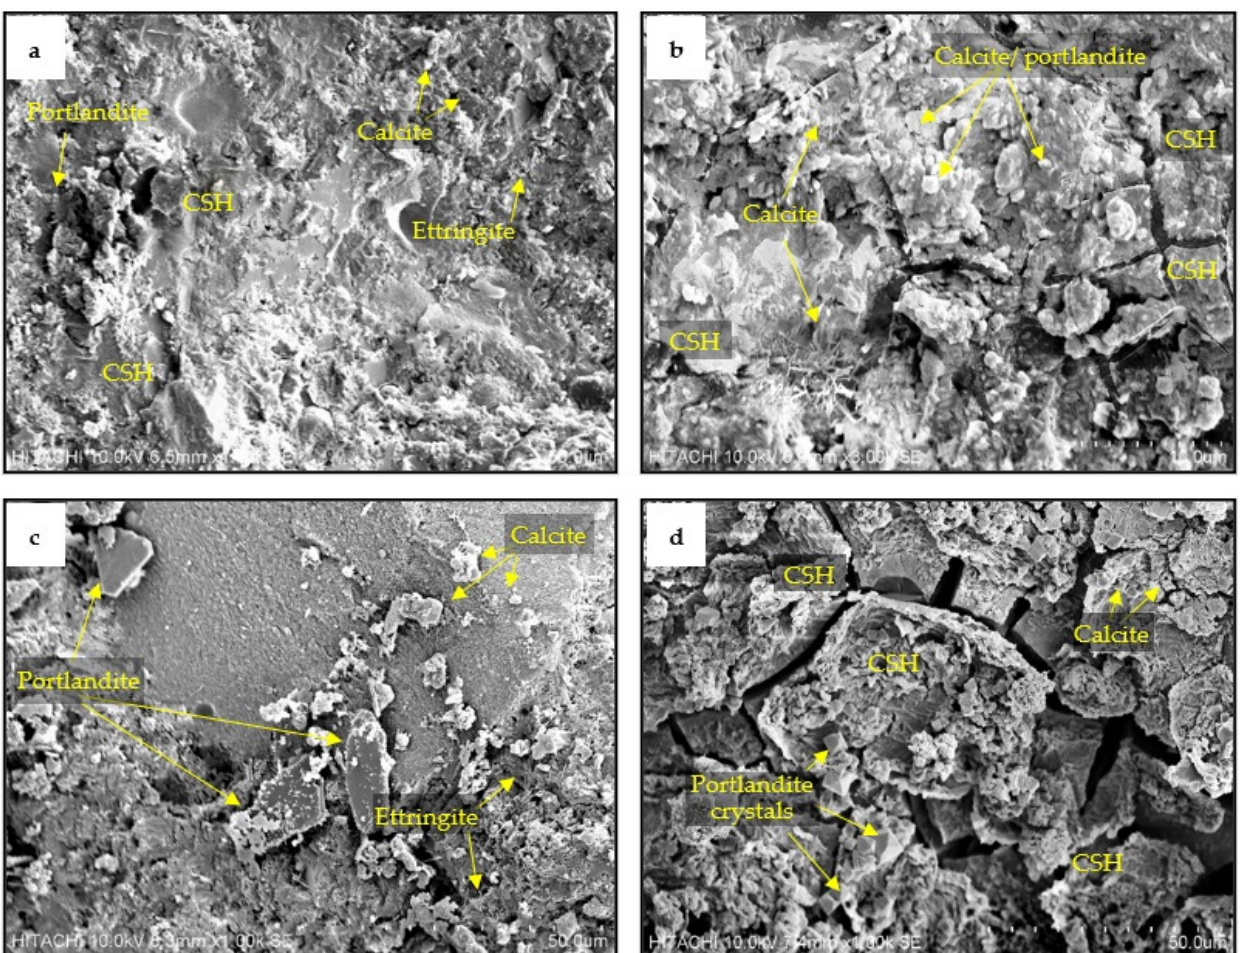
Figure 13. Development of healing compounds at 28 days for both 100%OPC (up) and 95%OPC + 5%SF (down). 100%OPC cement paste at the age of 28 days (a) without capsule, and (b) with capsules. 95%OPC + 5%SF cement paste at the age of 28 days (c) without capsule, and (d) with capsules.